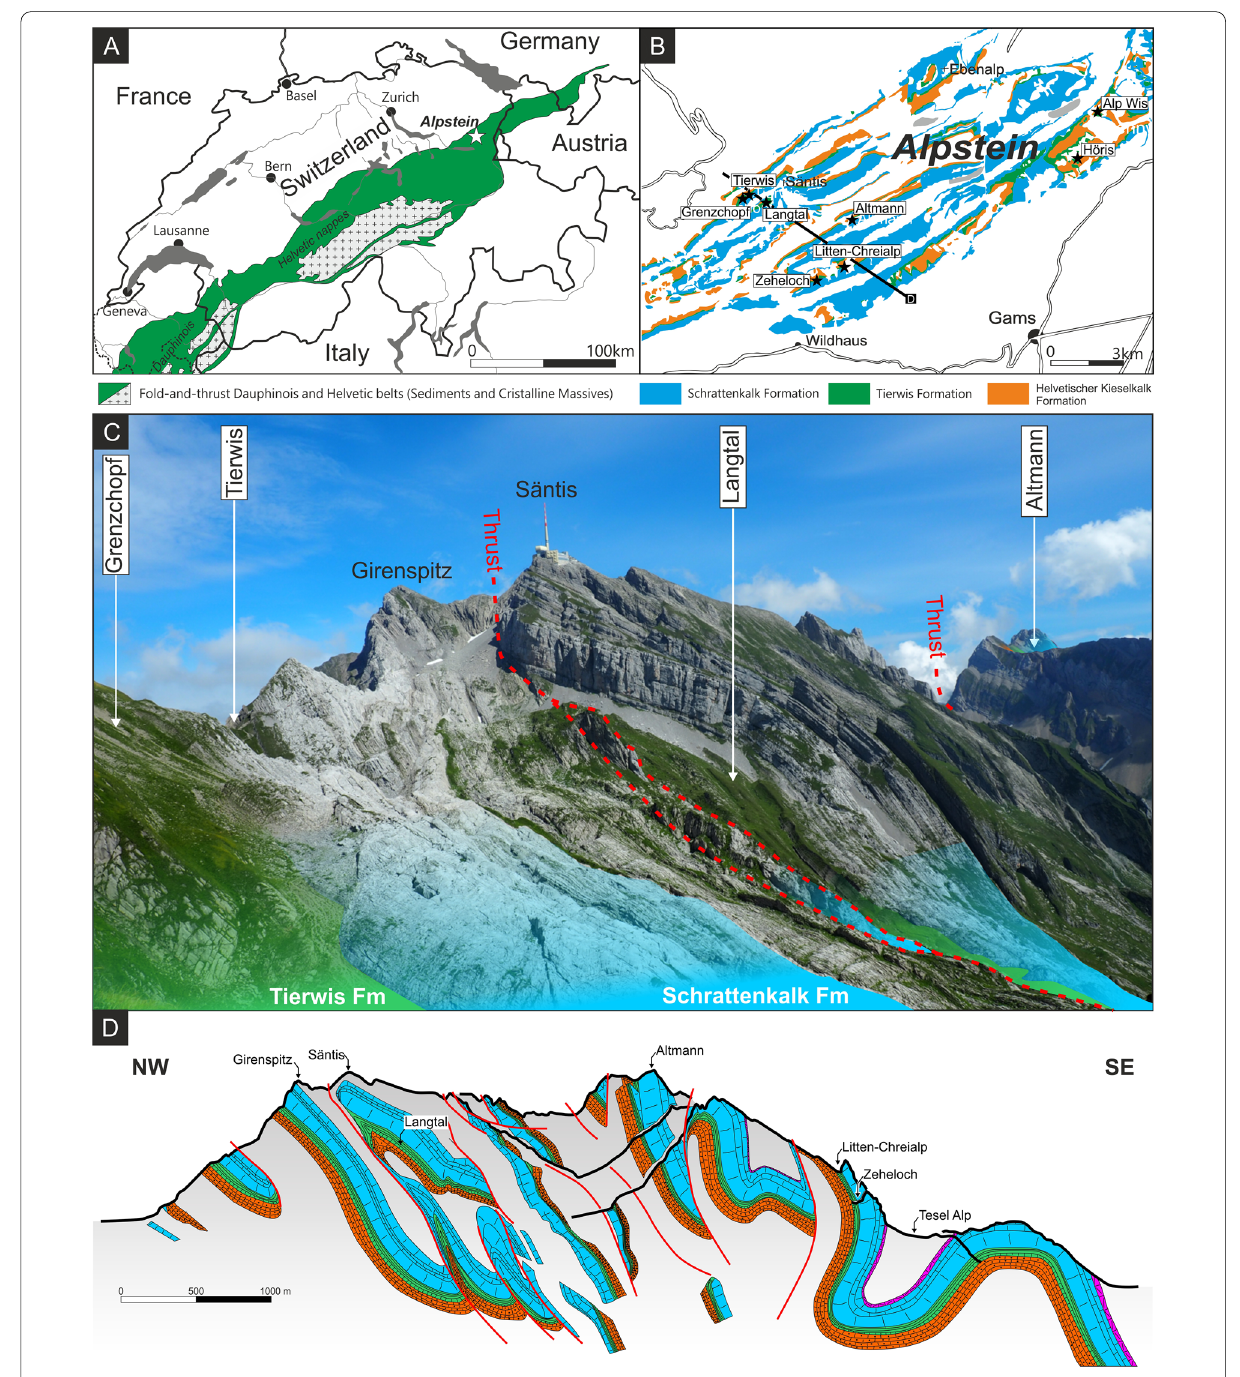
Fig. 1 A Location of the Alpstein massif on the Helvetic realm, simplified from Bodin et al. (2006a). B Simplified geological map with the location of the studied outcrops (modified after Eugster et al., 1982) with position of the cross-section illustrated at point D. C View of the Säntis part of the Alpstein massif with the position of some outcrops and the main thrusting faults. D Geological cross-section of the Alpstein massif modified after Kempf